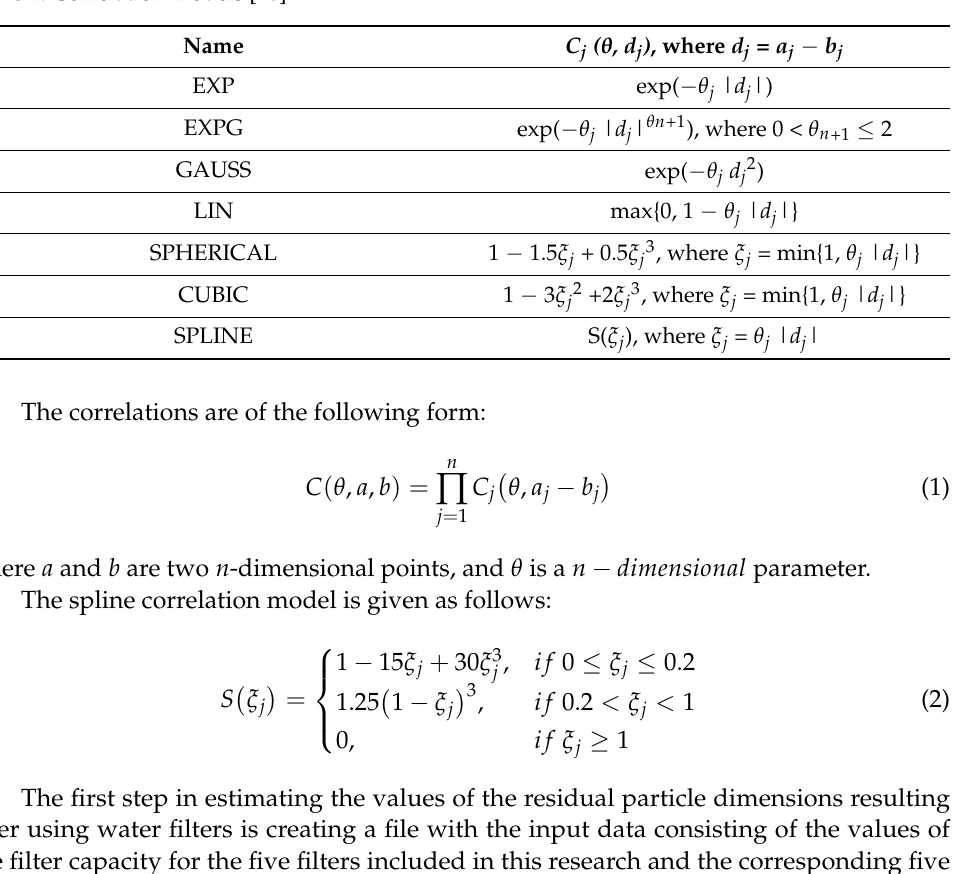
Table 1. Correlation models